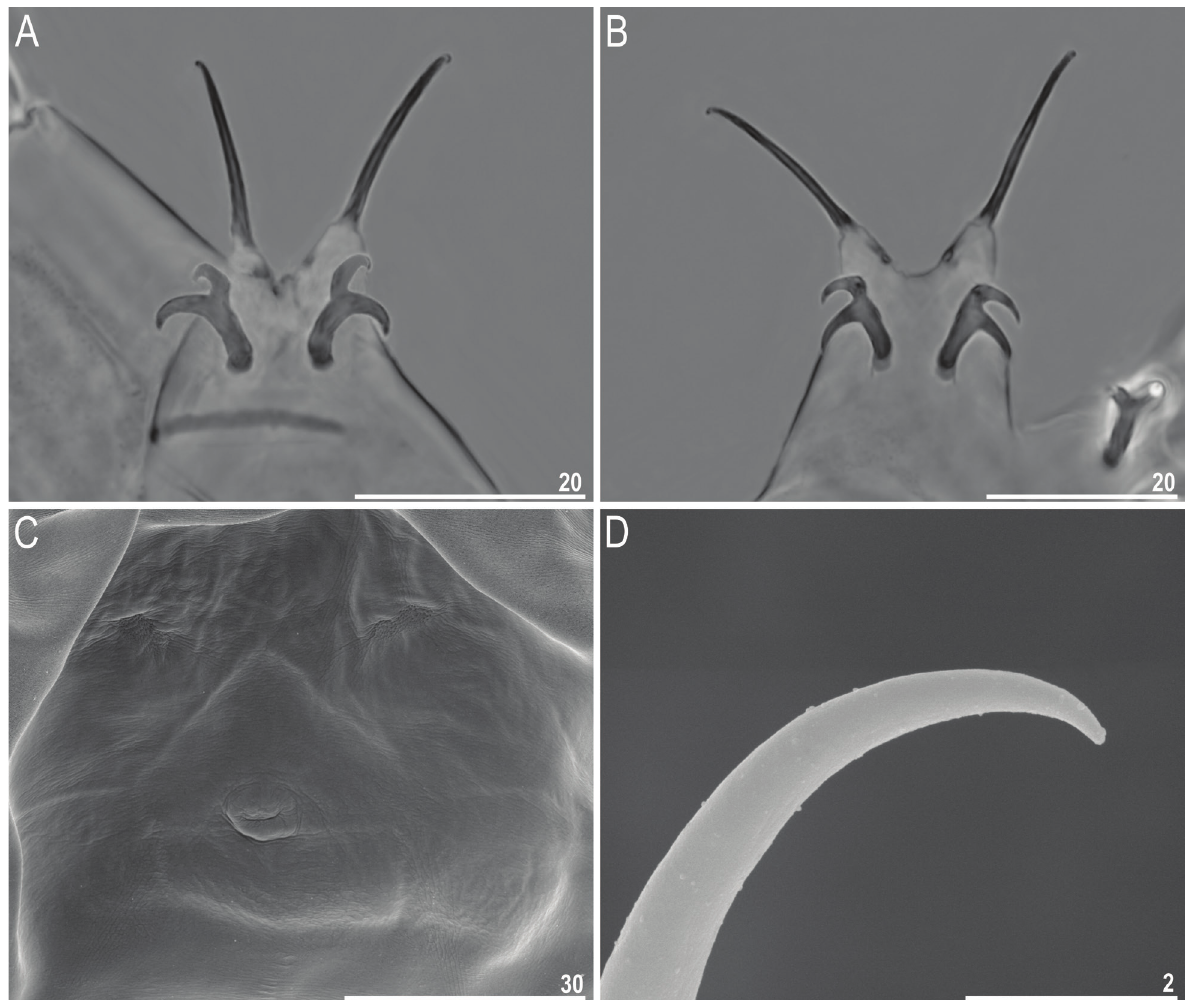
Figure 5. The morphology of claws of Milnesium reductum Tumanov, 2006 A Photograph of hatchlings claws III with a [2-2] CC, PCM; B Photograph of hatchlings claws IV with a [2-2] CC, PCM; C SEM photograph of claws II with a [2-3] CC lacking acces - sory points; D SEM photograph of tip of primary branch of claws lacking accessory points. All the scale bars are given in